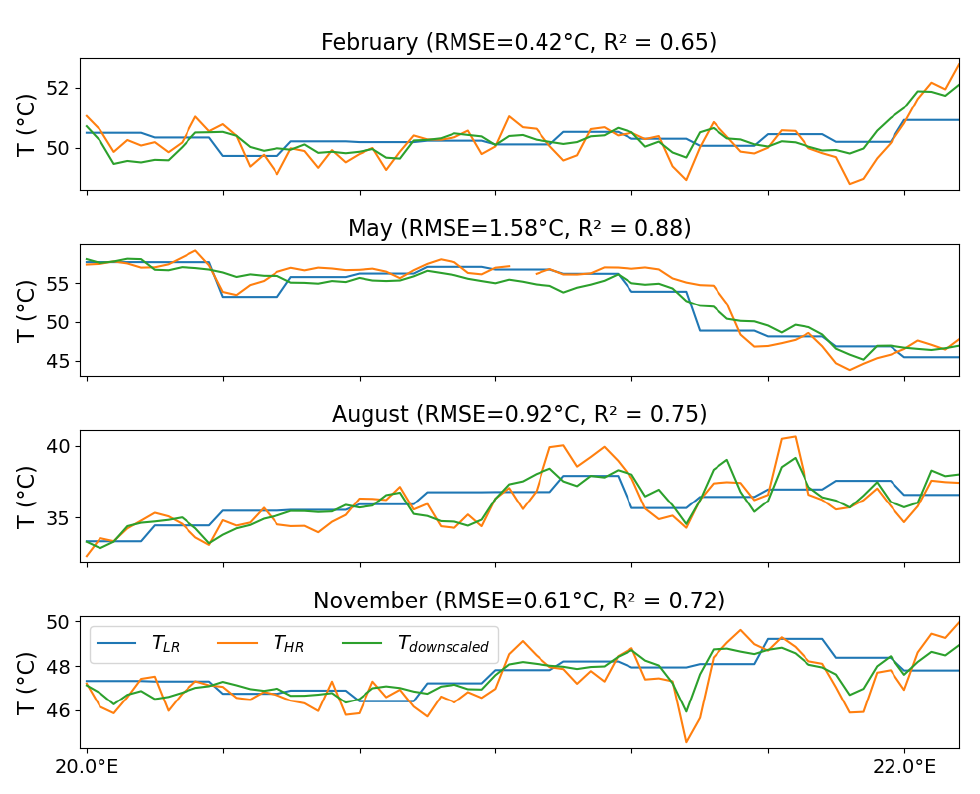
Figure 9. Transect of the T around 12.5 ◦ N between 20 ◦ E and 22 ◦ E at 10:00 on the 18th of the months of February, May, August and November (top to bottom). For each month, the SEVIRI T HR in orange, the 5 × 5 average T LR in blue and the T downscaled in green are shown. Also, the RMSD and coefficient of determination R 2 between the T downscaled and T HR is displayed in each subplot